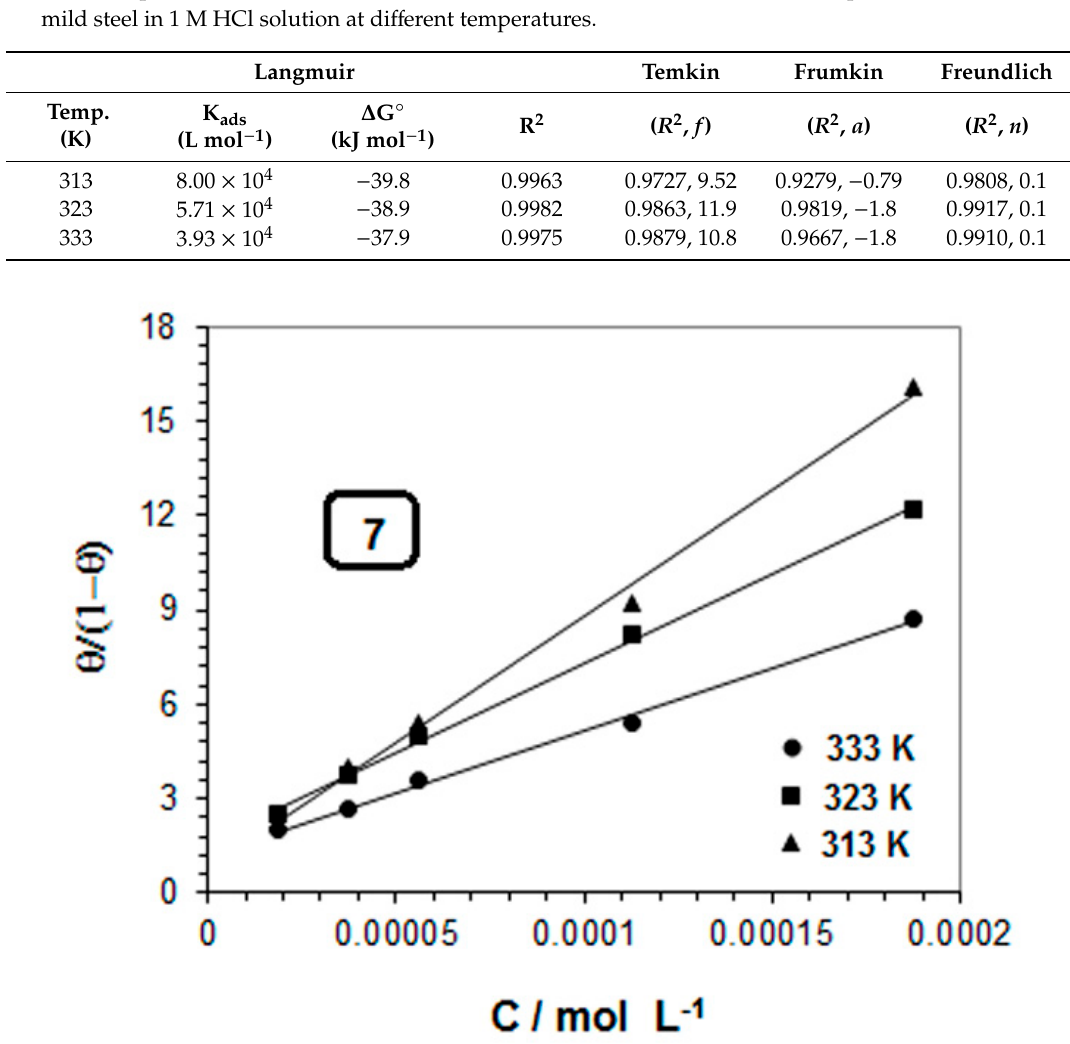
Figure 5. Langmuir adsorption isotherm for the corrosion inhibitor 7 in 1 M HCl at 313–333 K.